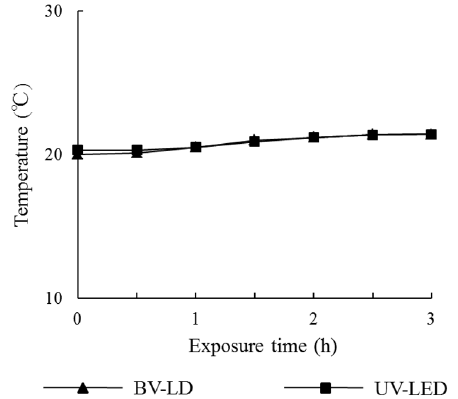
Figure 3. Temperature changes on the surface during each exposure.